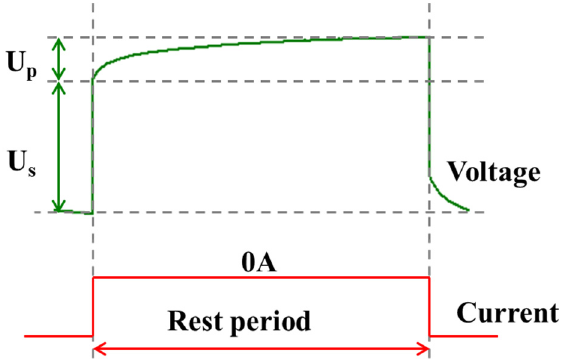
Figure 3. Voltage profile during the rest time period.